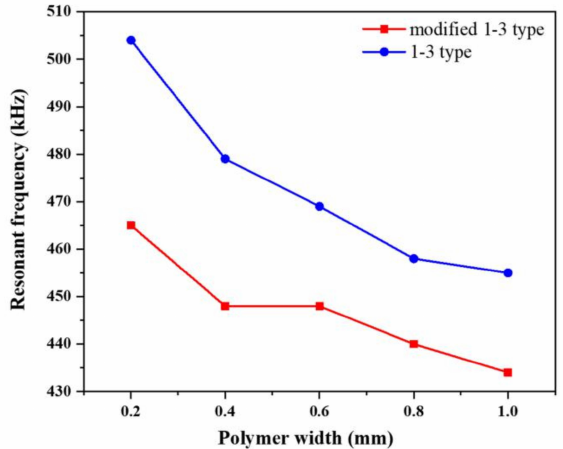
Figure 8. Effect curve of polymer width on resonant frequency of two types of